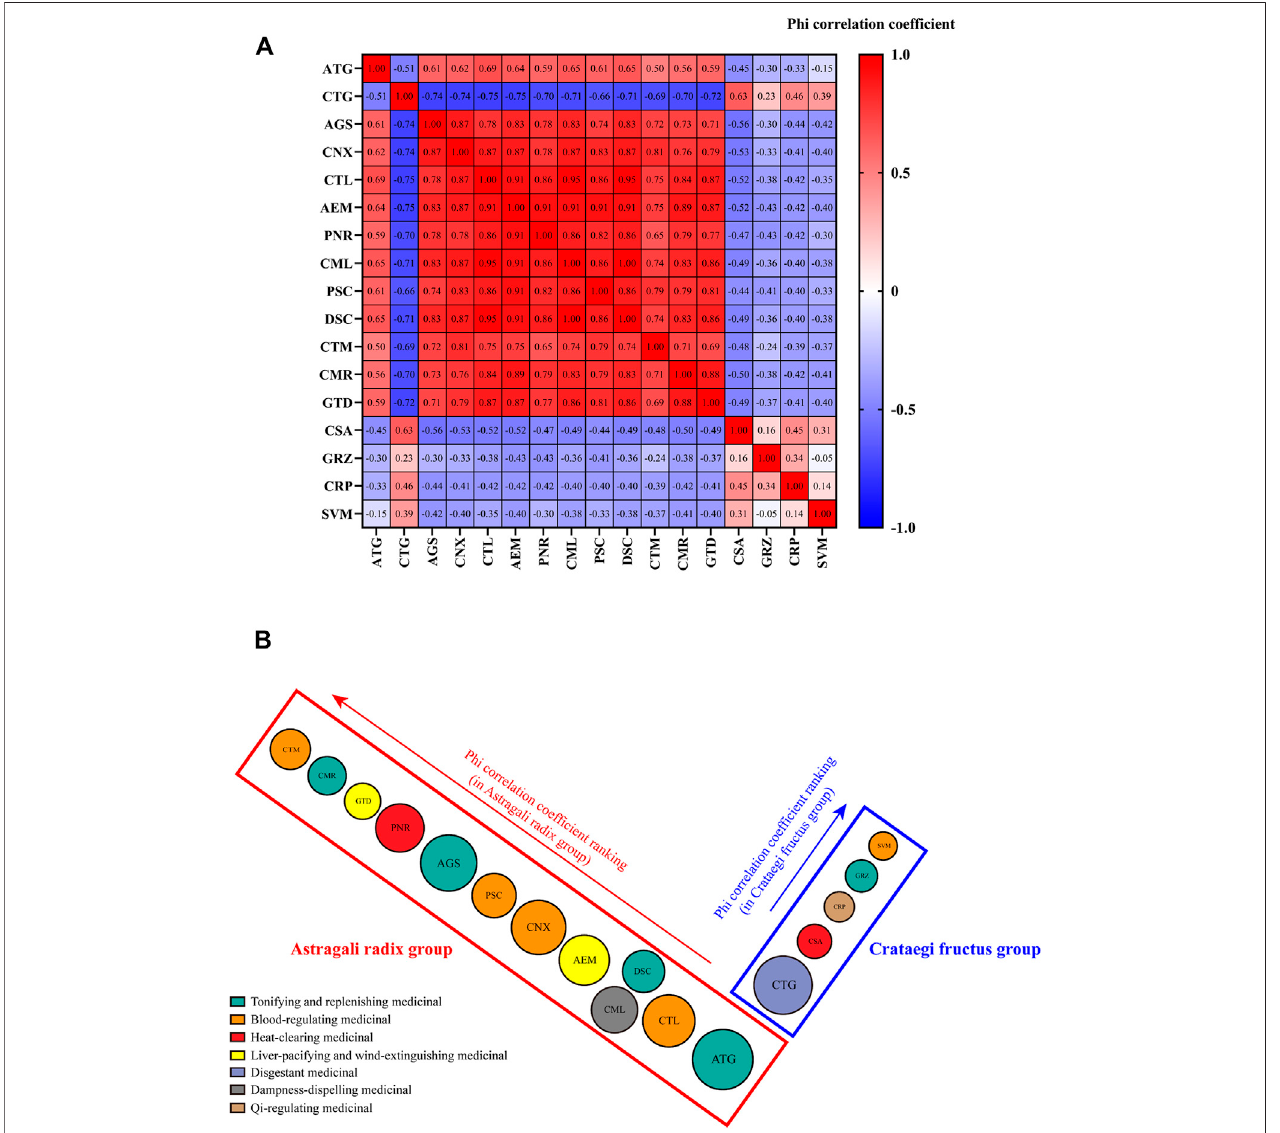
FIGURE3| Correlationof17commonlyusedmedicinalmaterials (A) Heatmap (B) Cladogram.ATG, Astragalusmongholicus Bunge;AEM, Amynthasaspergillum (E.Perrier);AGS, Angelicasinensis (Oliv.)Diels;CML, Chaenomelesspeciosa (Sweet)Nakai;CMR, Cynomoriumcoccineum subsp. songaricum (Rupr.)J.Léonard;CNX, Ligusticumstriatum DC.;CRP, Citrusreticulata Blanco;CSA, Sennaobtusifolia (L.)H.S.Irwin&Barneby;CTG, Crataeguspinnati fi da Bunge;CTL, Cyathulaof fi cinalis K. C. Kuan; CTM, Carthamus tinctorius L.; DSC, Dipsacus inermis Wall.; GRZ, Glycyrrhiza uralensis Fisch.;GTD, Gastrodia elata Blume; PNR, Paeonia lacti fl ora Pall.; PSC, Prunus persica (L.) Batsch; SVM, Salvia miltiorrhiza Bunge.